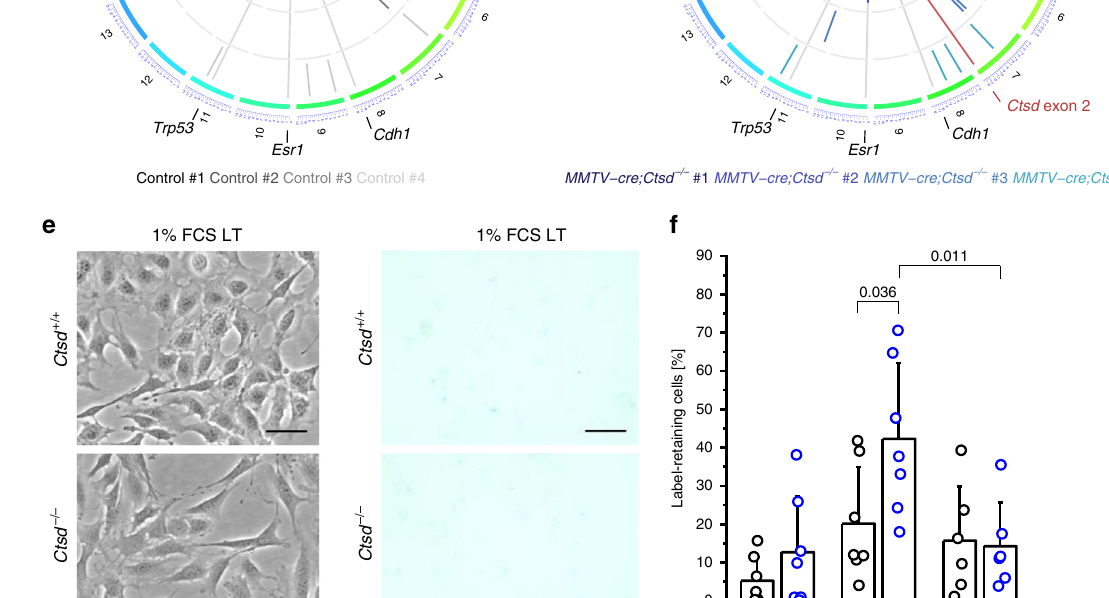
Ctsd +/+ Ctsd –/– Ctsd +/+ Ctsd –/–